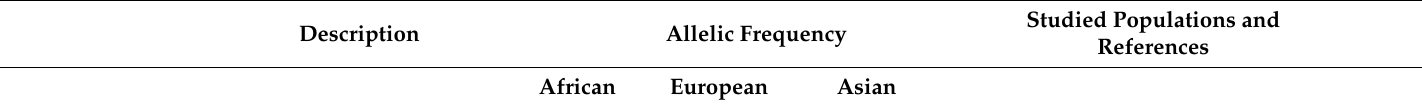
Table 1. Summary of APOBEC3 variations and their